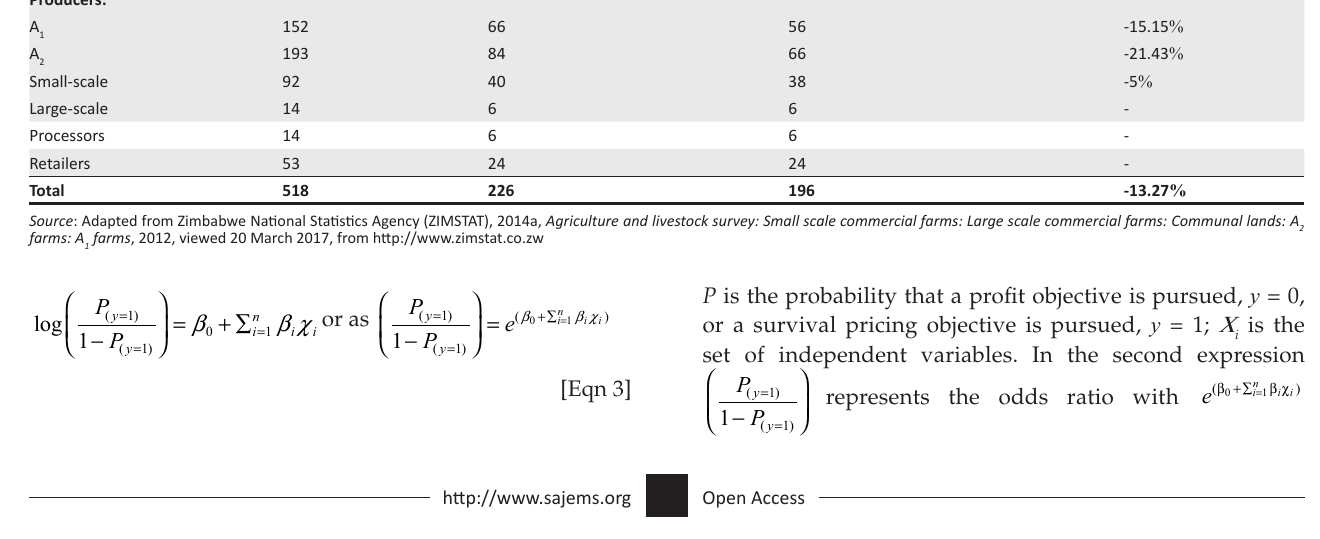
FIGURE 1: Geographical location of Mashonaland Central TABLE 1: Sample size. Industry player Population Sought-after responses (sample) Actual responses (sample)